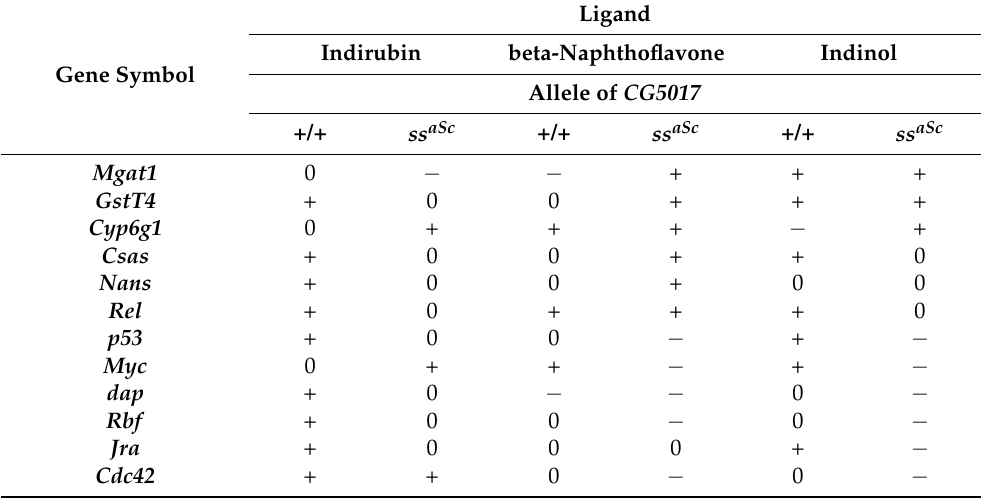
Table 1. The decreased expression of nucleotropic chaperone CG5017 activates ligand-dependent transcription of some AHR target genes. Summarized results of real-time PCR experiments shown on